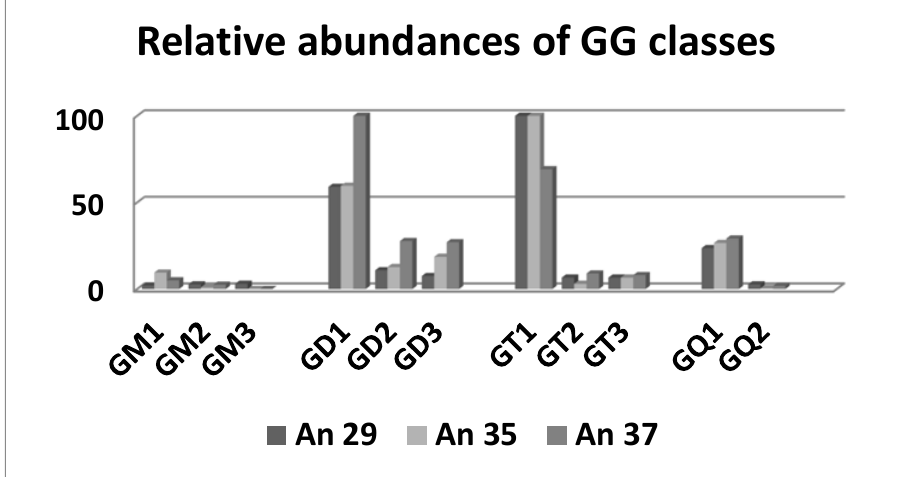
Figure 1. Histogram plotting the changes in the relative abundances of GG classes in An29, An35, and An37 (reprinted with permission from [138]).